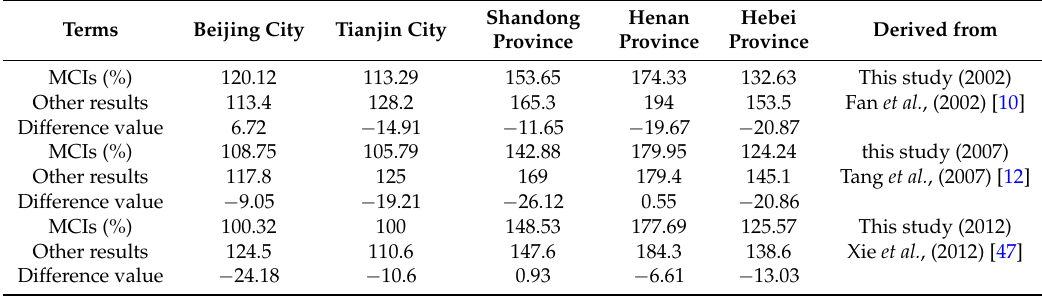
Table 3. Comparison of the differences in remote sensing monitoring results of other studies in the North China